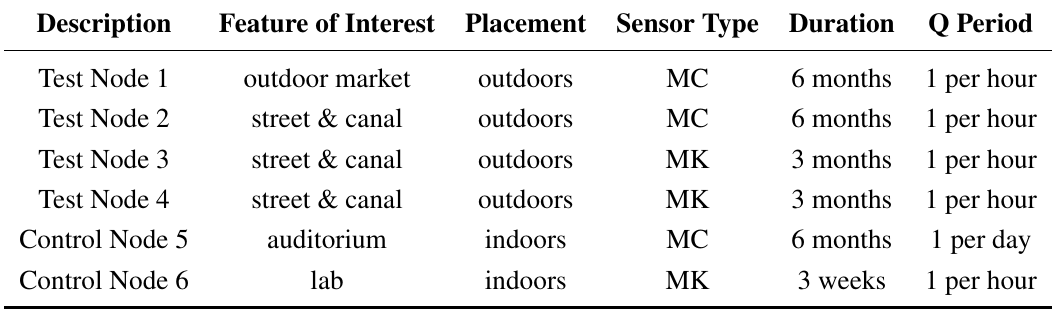
Table 3. To test the capacity of Q to estimate sensor quality in an outdoors environment, four nodes were placed outdoors to measure the environmental noise produced by an urban feature of interest for a period of several months. They were equipped with our self-test noise sensors (types MC and MK) which measured Q hourly. Additionally, two nodes were kept indoors to serve as a control group.